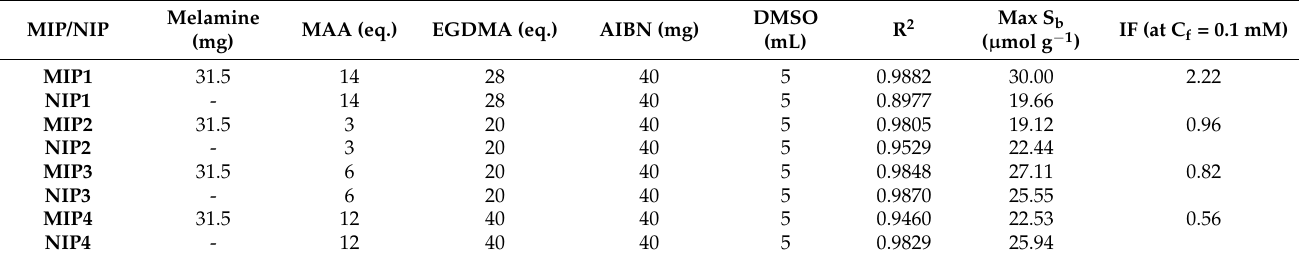
Table 1. Synthesized MIP/NIP